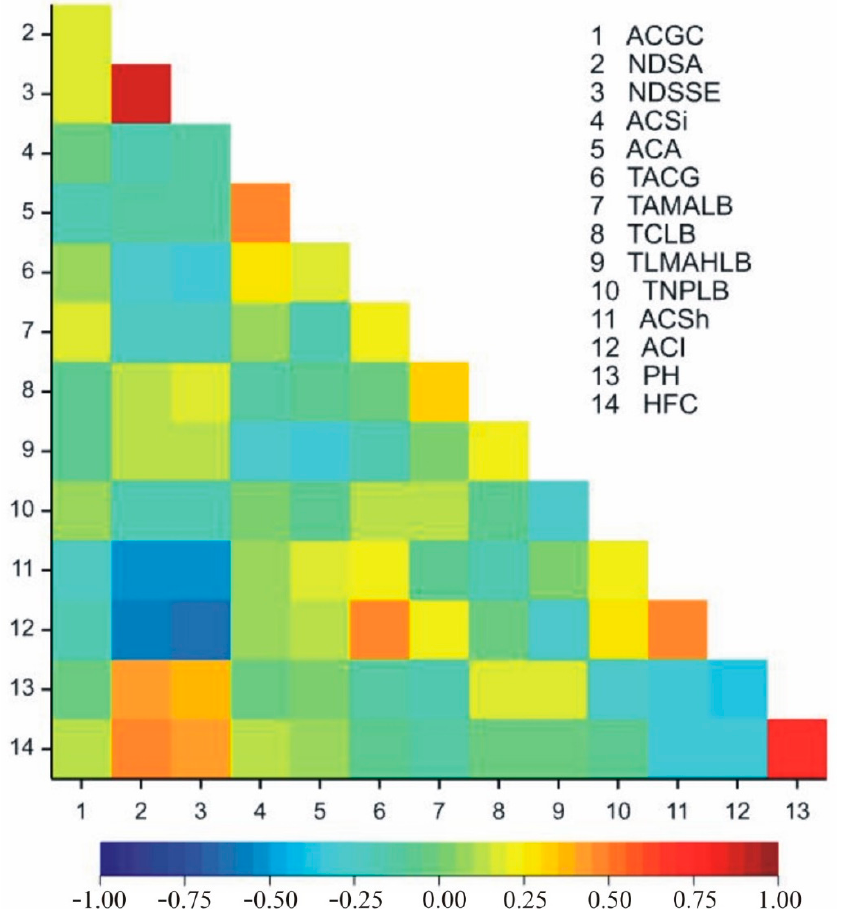
Figure 2. Heatmaps for linear Pearson’s correlation coefficients between the observed traits on the basis of mean values for inbred lines. ACGC-anthocyanin coloration of cob glumes, NDSA—number of days from sowing to anthesis, NDSSE—number of days from sowing to silk emergence, ACSi- anthocyanin coloration of silks, ACA-anthocyanin coloration of anthers, TACG-tassel: anthocyanin coloration at glume base, TAMALB—tassel: angle between the axis and lateral branches, TCLB— tassel: curvature of lateral branches, TLMAHLB—tassell: length of the main axis above the highest lateral branch, TNPLB—tassel: number of primary lateral branches, ACSh—anthocyanin coloration of the sheath, ACI—anthocyanin coloration of internodes, PH—plant height, HFC—height of the first cob.